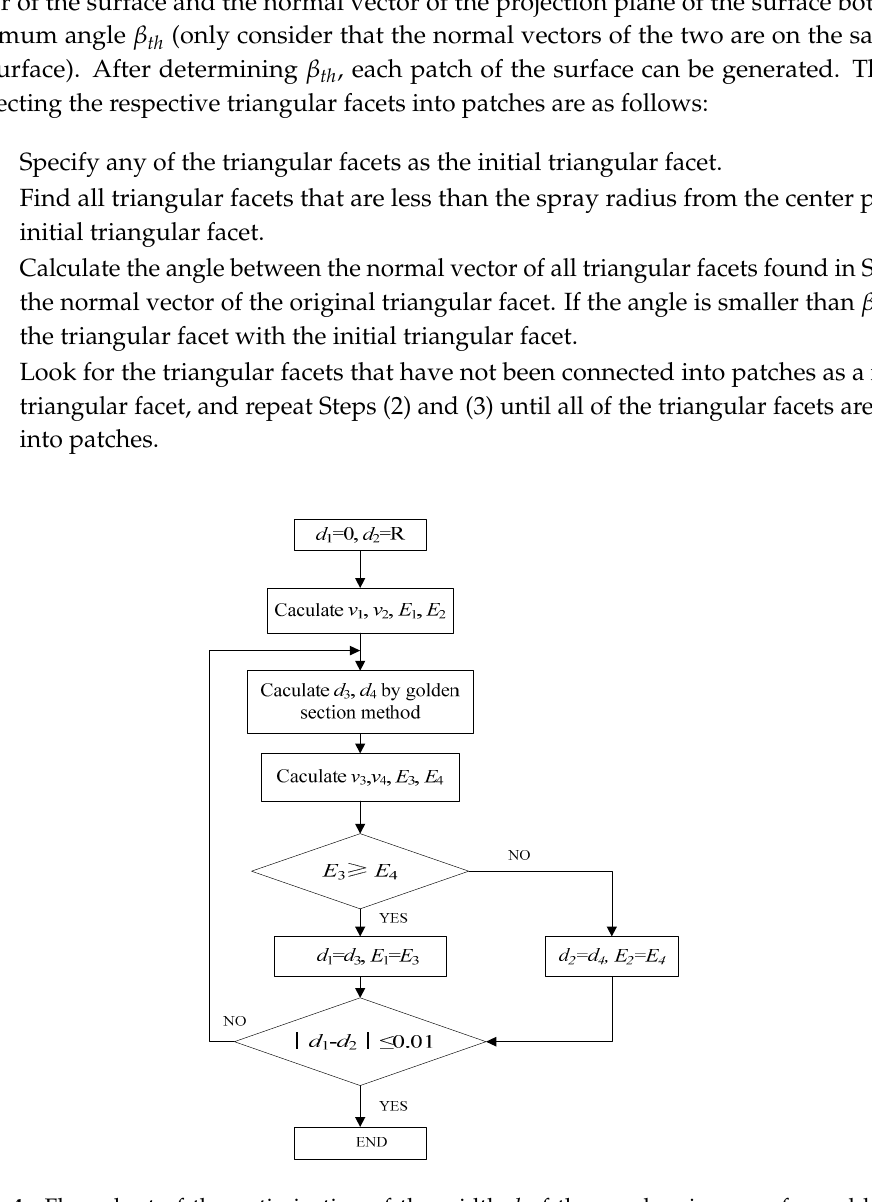
Figure 4. Flow chart of the optimization of the width d of the overlapping area formed by two spray ‐ painting strokes.